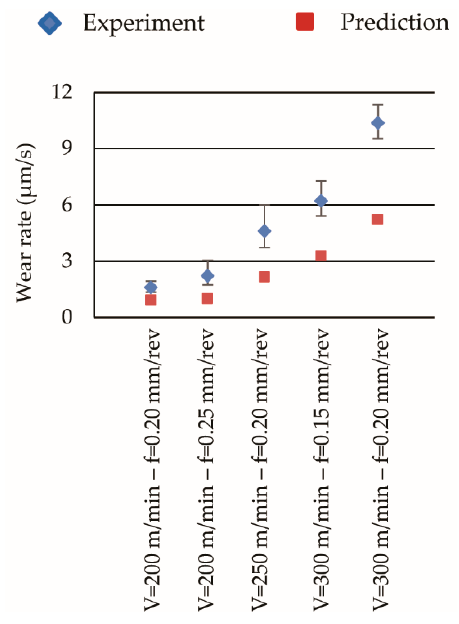
Figure 10. Wear rates predictions corresponding to the initial cutting period.